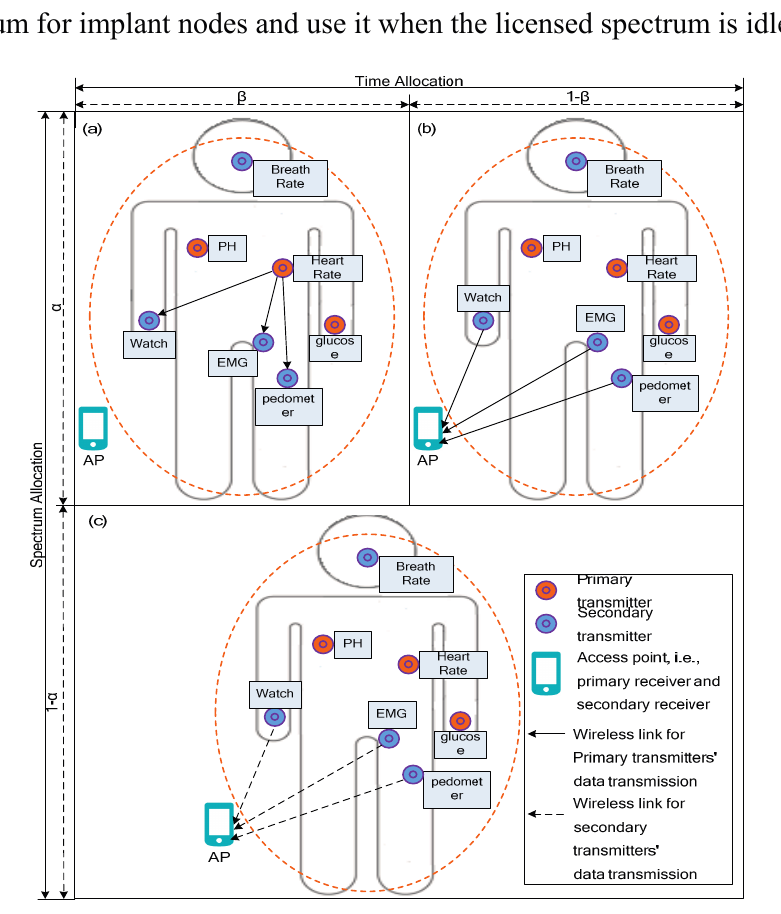
Figure 1. The time-spectrum allocation of primary user and secondary users in active cooperation mechanism: ( a ) in fraction αβ of the time-spectrum slot, PT broadcast data to ST i in selected secondary subset S ; ( b ) in fraction α (1 − β ) of time-spectrum slot, all ST i cooperatively transmit primary data to PR; ( c ) in fraction α of spectrum slot, ST i transmit their own data to